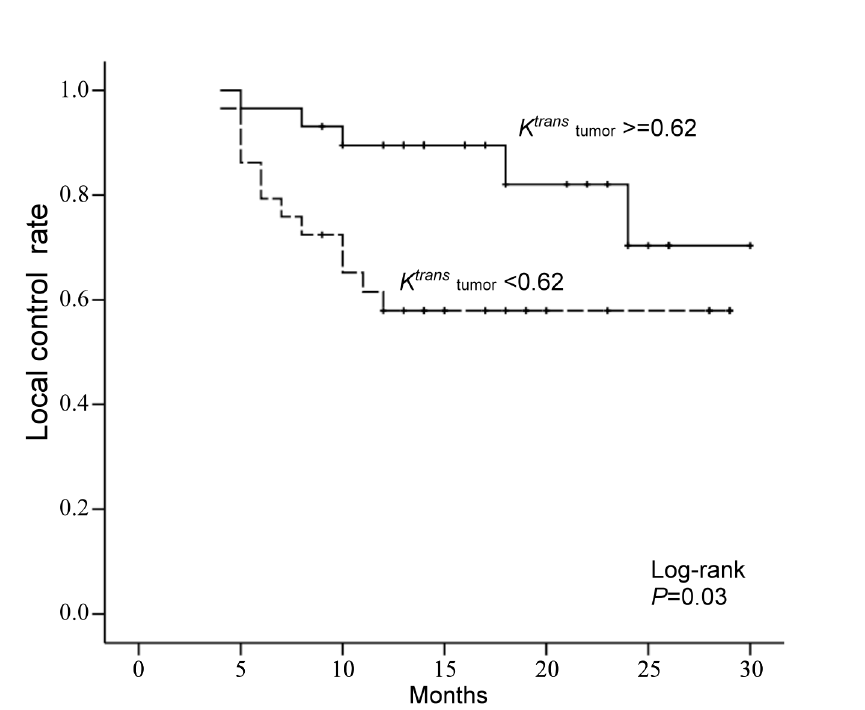
Figure 1. Kaplan-Meier analysis of local control rate stratified according to the median value of K trans . doi: